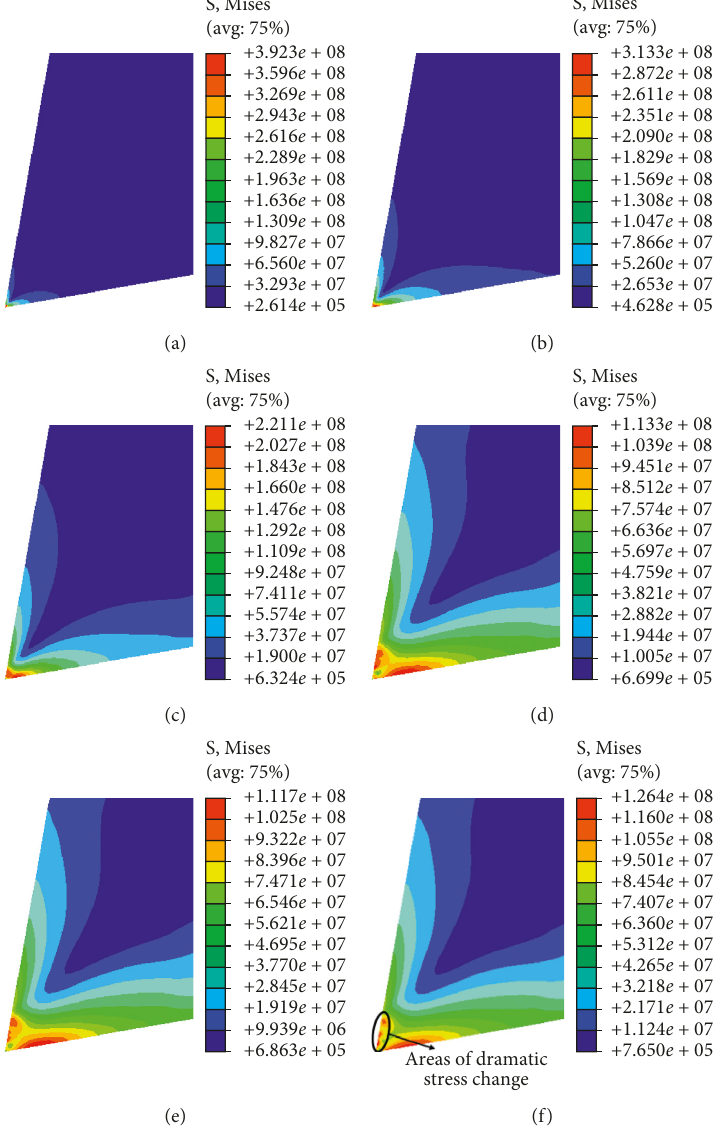
Figure 3: Stress distribution on the cutting tool ( α � 10 ° , H � 10 mm, and V � 1.36m/s): (a) t � 0.35ms; (b) t � 0.7 ms; (c) t � 1.05ms; (d) t � 1.75ms; (e) t � 35 ms; (f) t � 70ms.